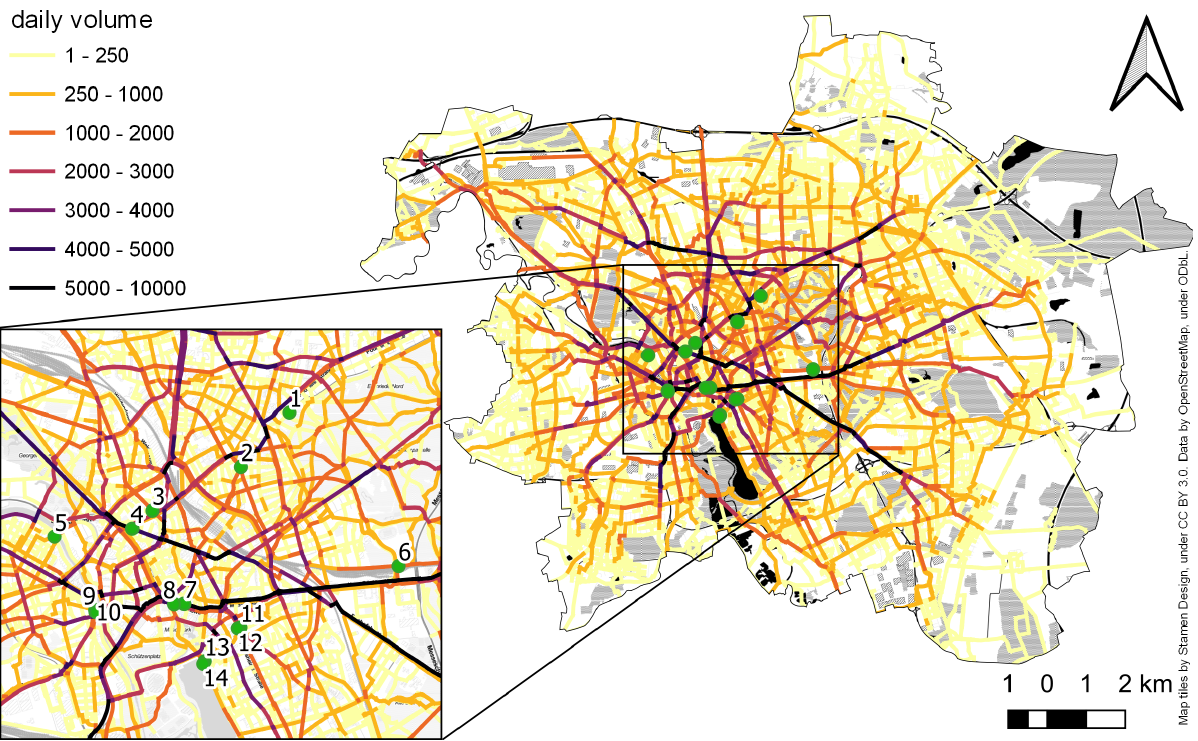
Figure 2. Simulated cyclist volume in the study area (Hanover, Germany), symbolized by light yellow (low volume) to dark black (high volume). Bicycle counting stations are marked with